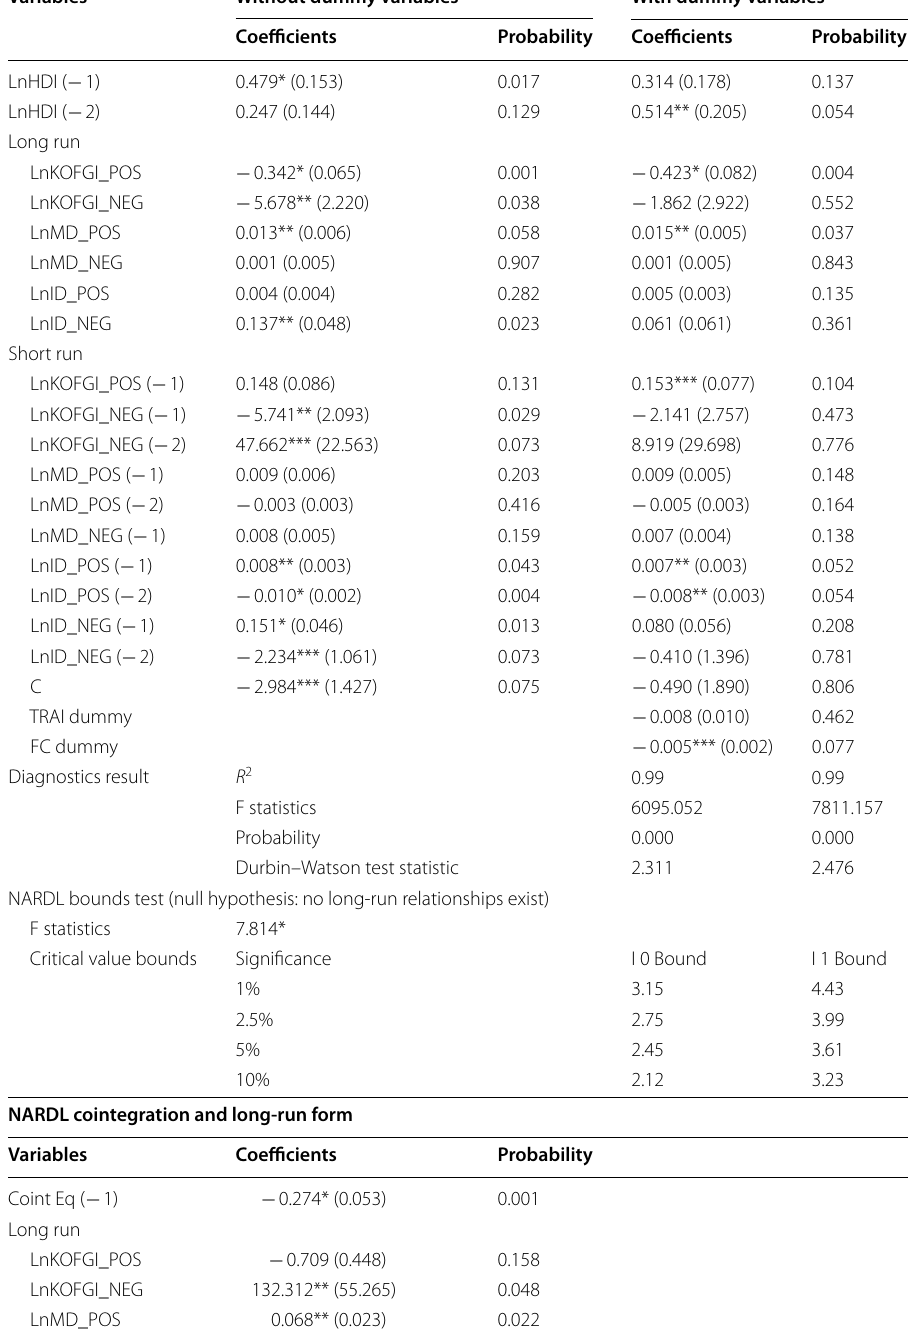
Table 7 Results of NARDL